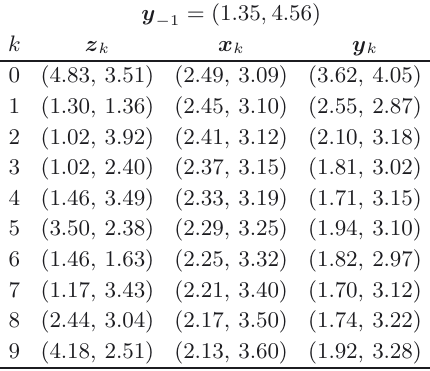
Table 2. Measured ( z ), theoretical ( x ), and estimated ( y ) vectors of Figure